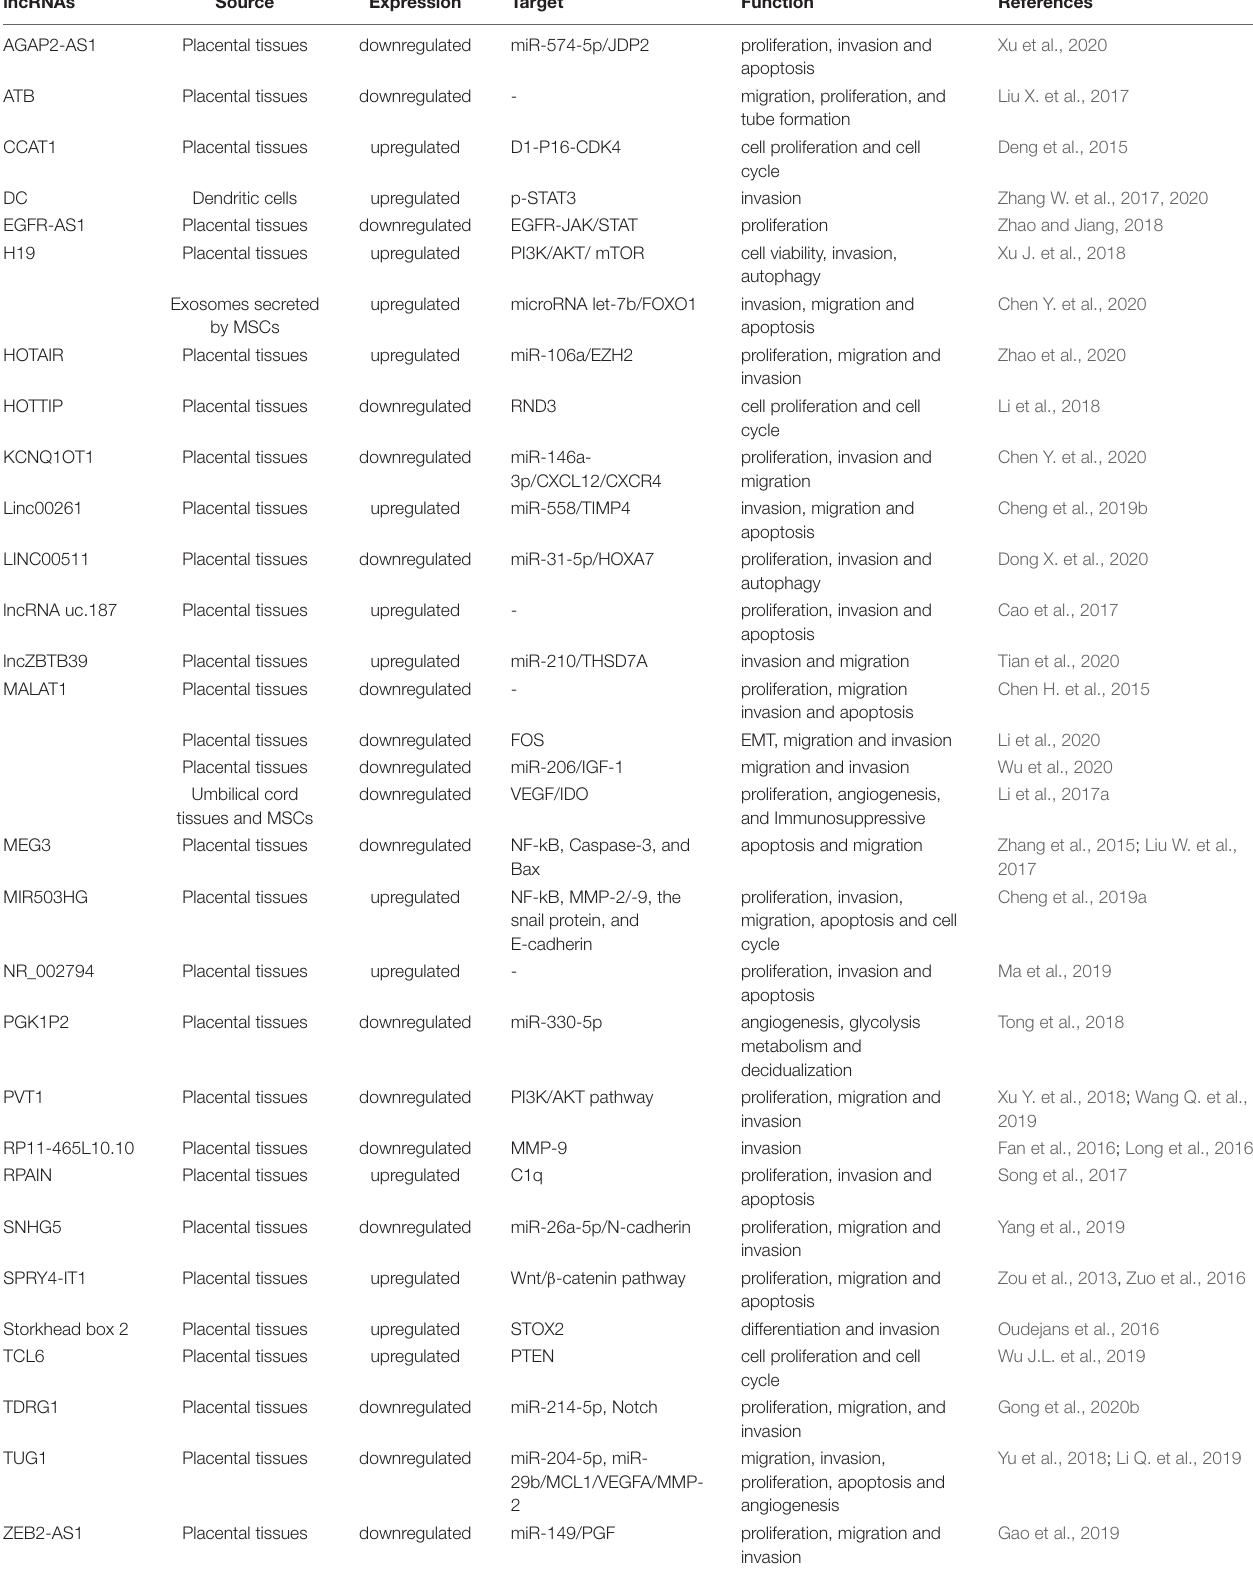
TABLE 2 | LncRNAs in the pathogenesis of